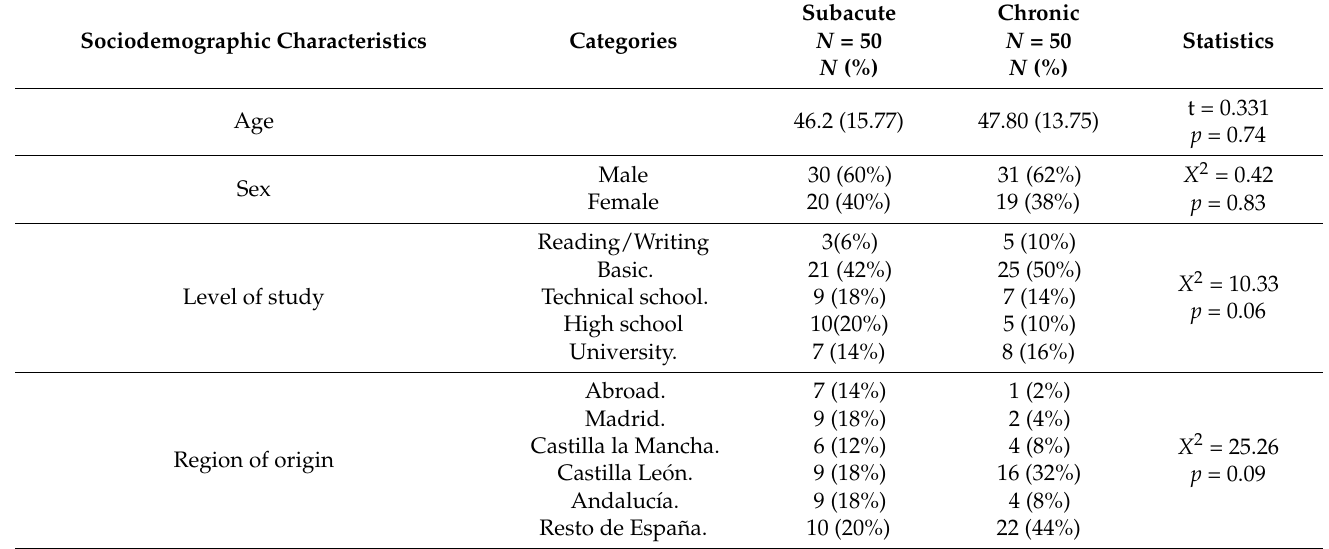
Table 1. Sociodemographic characteristics of spinal cord injury (SCI) patients.